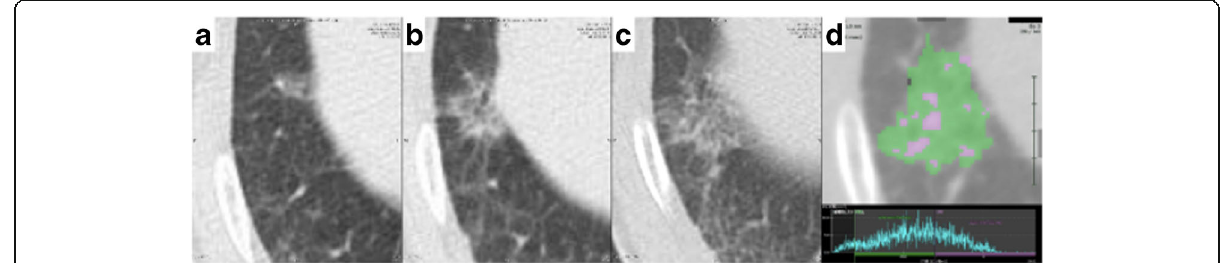
Fig. 1 A series of computed tomography images of a squamous cell carcinoma with ground glass nodule. a Chest computed tomography (CT) image showing a 7-mm ground glass nodule (GGN) in the right lower lobe when the lesion was first noted. b Chest CT, obtained 1 year after a ; the GGN has enlarged to 18 mm. c Chest CT image obtained 1.5 year after a ; the GGN has enlarged to 24 mm and a solid component has developed. d In a semi-automated three-dimensional volumetric “ GGN analysis ” of c , the ground glass opacity component ( green area , between − 800 and − 301